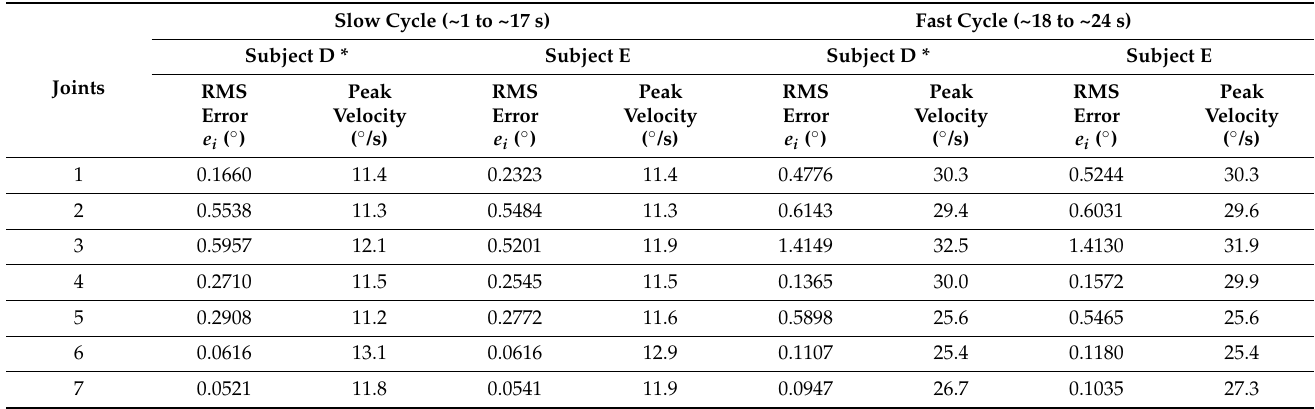
Table 8. Statistical analysis of tracking error and peak velocities, while Subjects D and E remain passive during all seven joints’ motion.